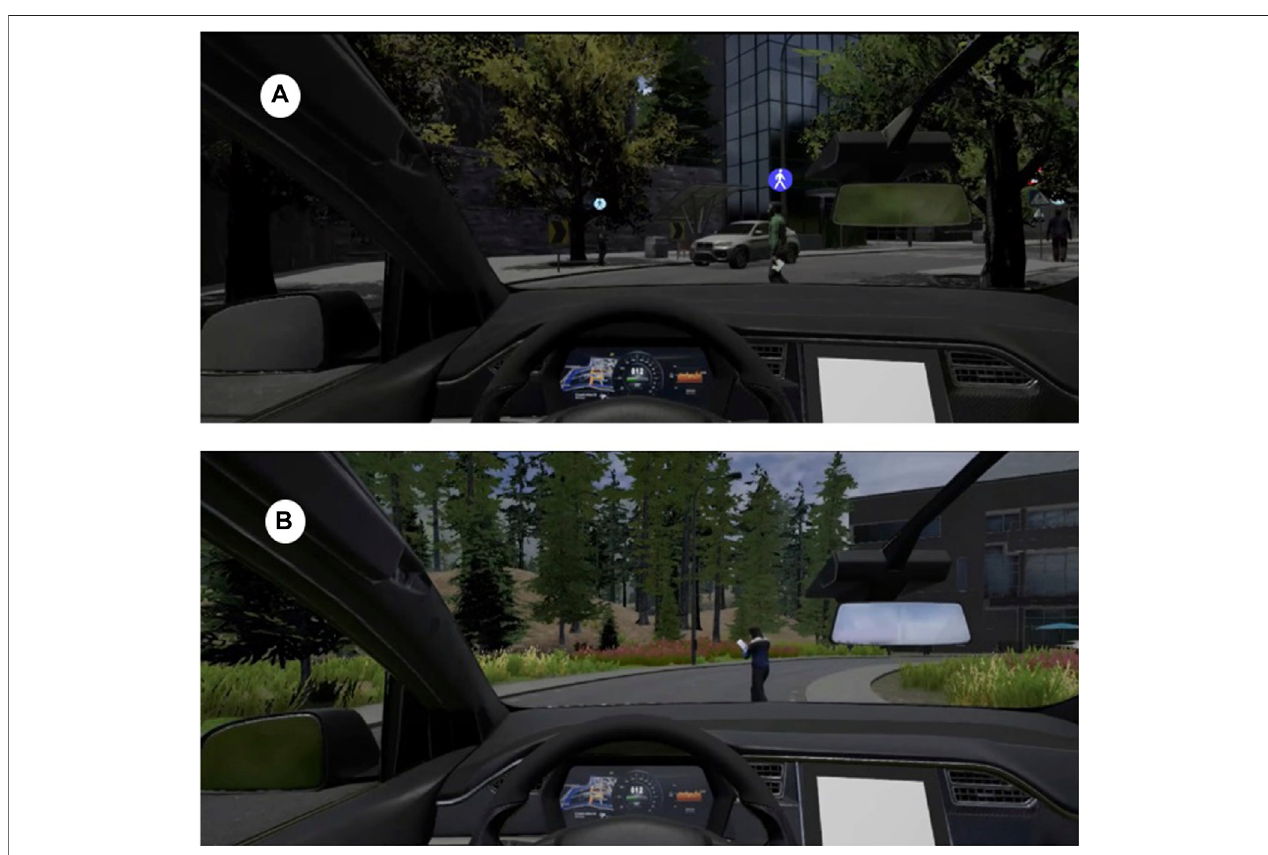
FIGURE 2 | Example scenarios for the three independent variables, (A) no malfunction, system working correctly and displaying a dark blue circle above the crossing pedestrian ’ s head ( system factor: no malfunction ), the crossing pedestrians is not using a smartphone ( context factor: no distraction ), and other vehicles and pedestrians are present ( context factor: situation complexity high ) (B) malfunction of the system, no circle is displayed above the crossing pedestrian ’ s head ( system factor: malfunction ), the crossing pedestrian is using a smartphone ( context factor: distraction ), and no other vehicles and pedestrians are present ( context factor: situation complexity low